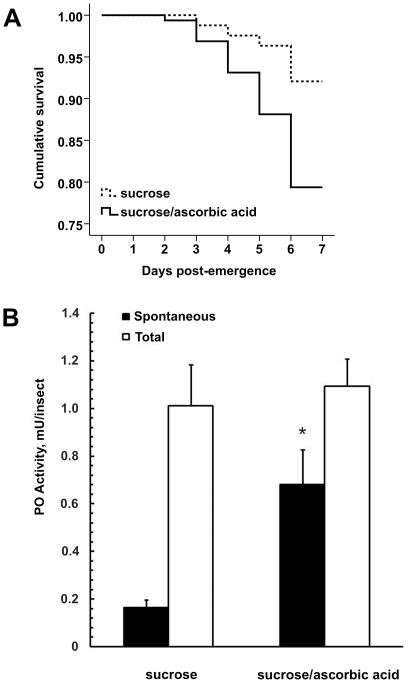
Effect of dietary supplementation of ascorbic acid on mortality of sugar fed Lu. longipalpis.(A) Female sand flies were offered a 70% sucrose solution supplemented with 20 mM ascorbic acid or a non-supplemented sucrose solution. Experimental flies (sucrose +20 mM ascorbic acid) exhibited a significantly lower survival rate compared to control flies, (p<0.001, Kaplan-Meier, Log Rank χ2 test). (B) Spontaneous and total phenoloxidase (PO) activity in Lu. longipalpis females after 7 days of feeding with 70% sucrose solution or 70% sucrose solution supplemented with 20 mM ascorbic acid. Spontaneous PO activity in ascorbic acid supplemented flies was significantly higher than control flies (P<0.05 , T-test). Results are mean ± SEM from 2 independent experiments with 10 sand flies per experiment.